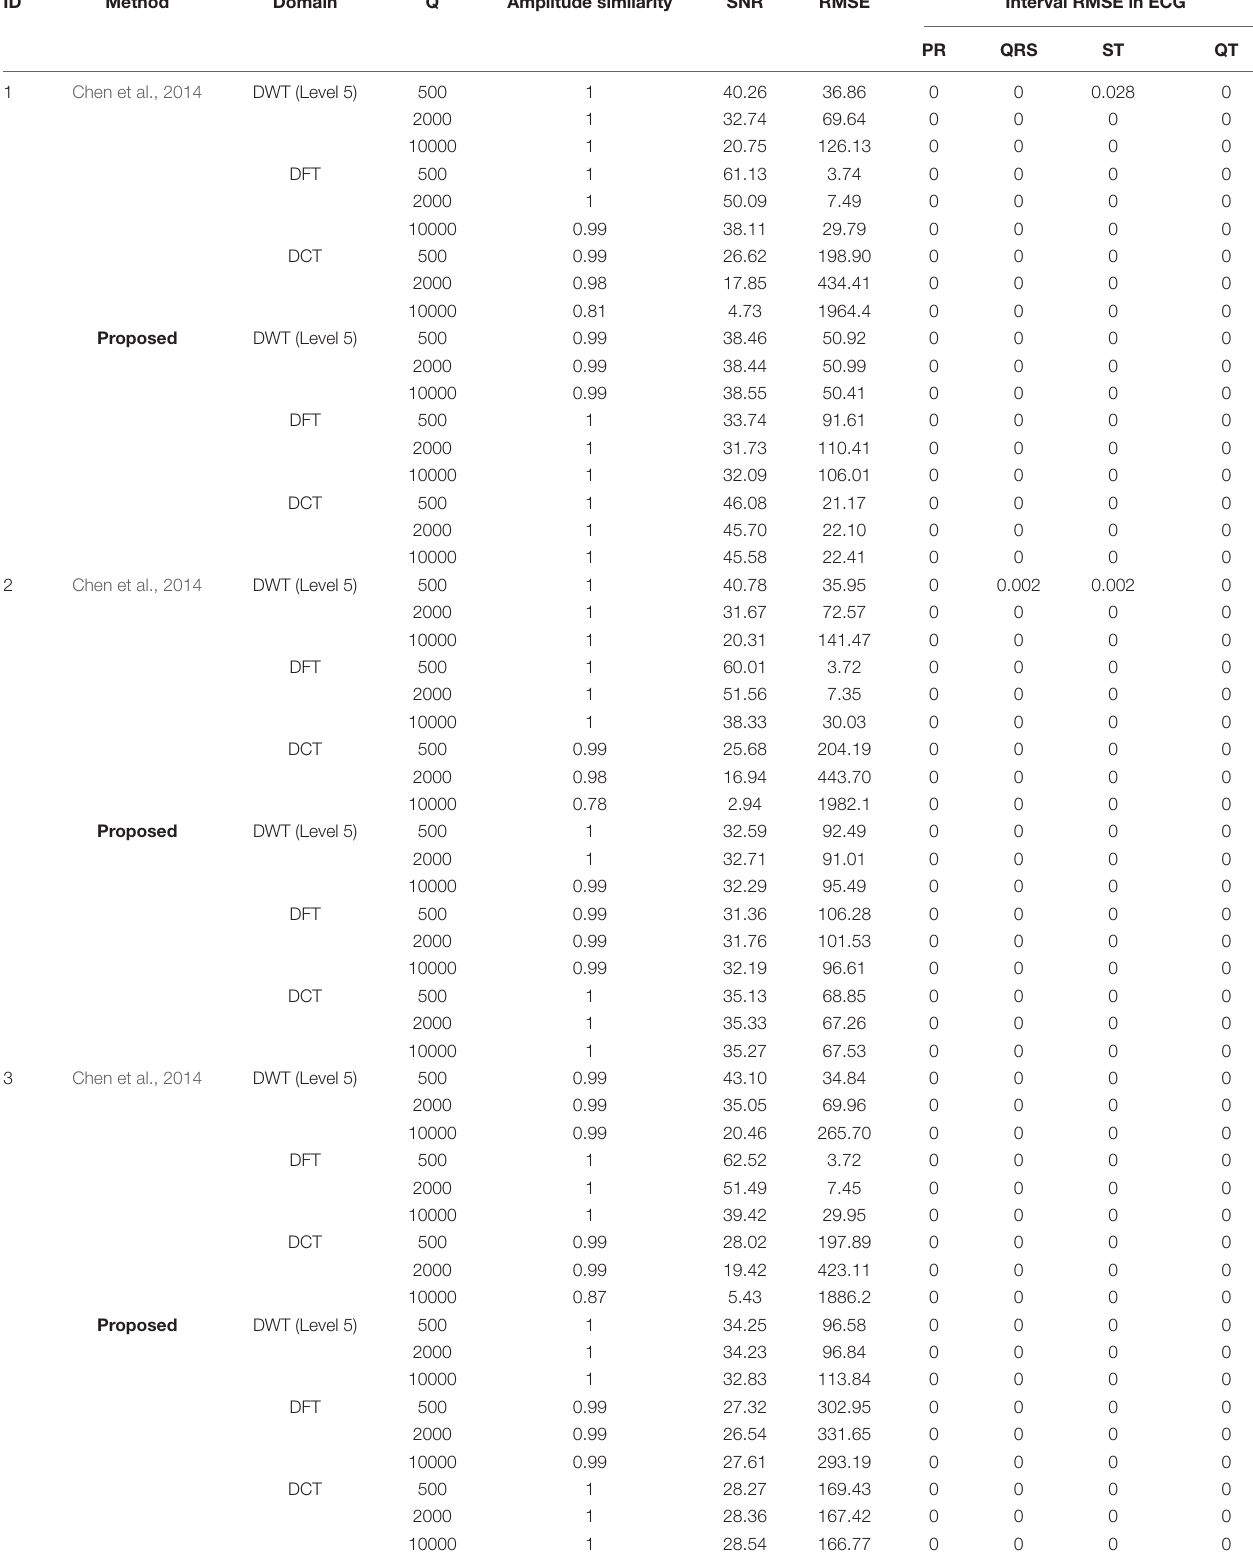
TABLE 1 | Experimental results for the three transforms: discrete wavelet transform (DWT), discrete cosine transform (DCT), and discrete Fourier transform (DFT). ID